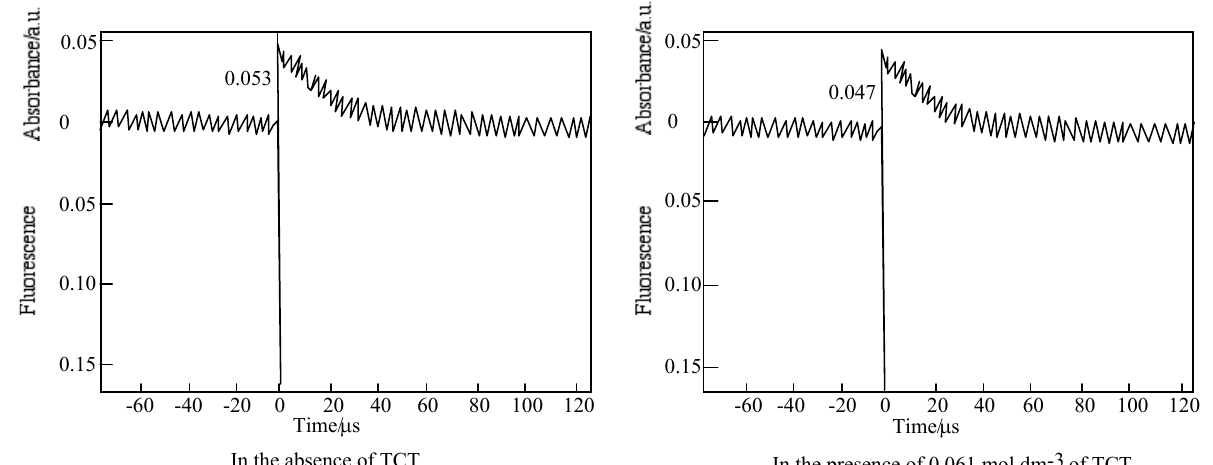
Figure 18. Decay trace of 6 in PMMA film on 450 nm. Excitation wavelength: 355 nm in the presence and absence of TCT. Substance concentration; 0.15 mol·L -1 ; Excitation wavelength; 355